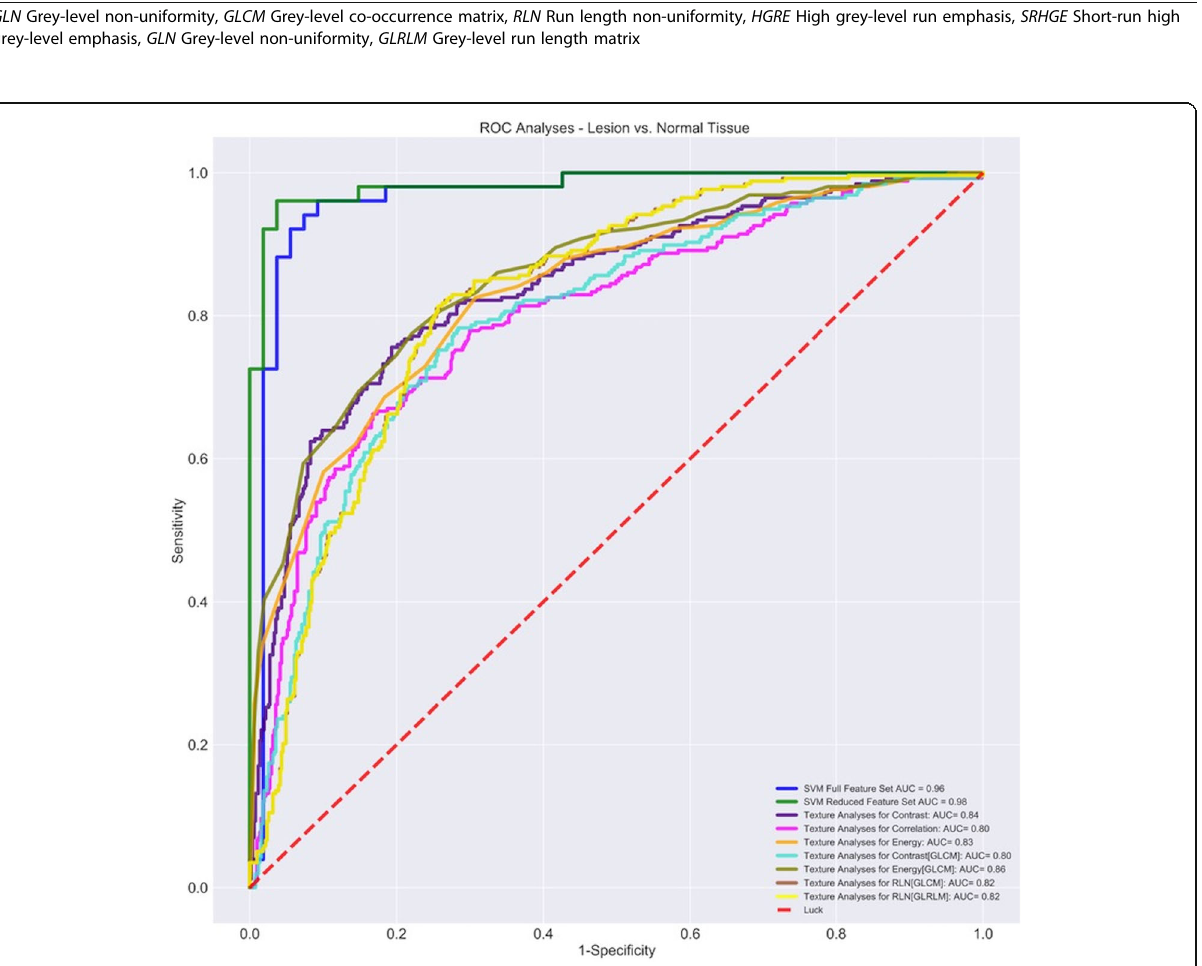
Fig. 2 Receiver operating characteristic (ROC) curves of texture analysis features with the highest area under the curve values (Table 2) as well as ROC curves obtained with machine learning support vector machine (SVM) algorithm with full and reduced features when used to compare lesions versus normal tissue on automated breast